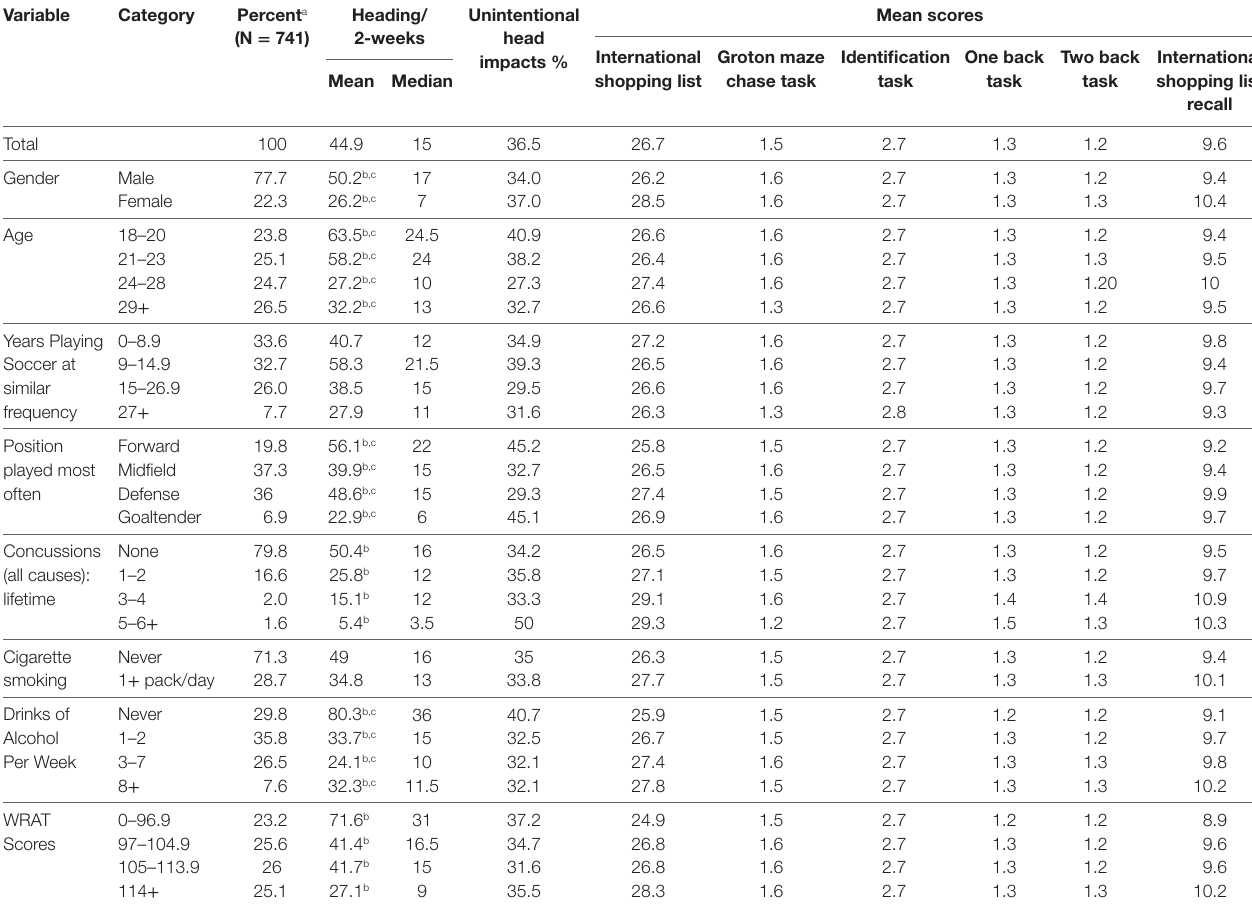
Table 2 | Descriptive statistics on intentional (heading) and unintentional head impacts and neuropsychological (NP) scores by demographic and other factors using data from the 741 HeadCounts-2w and the in-person NP assessments. Variable category Percent a (n =